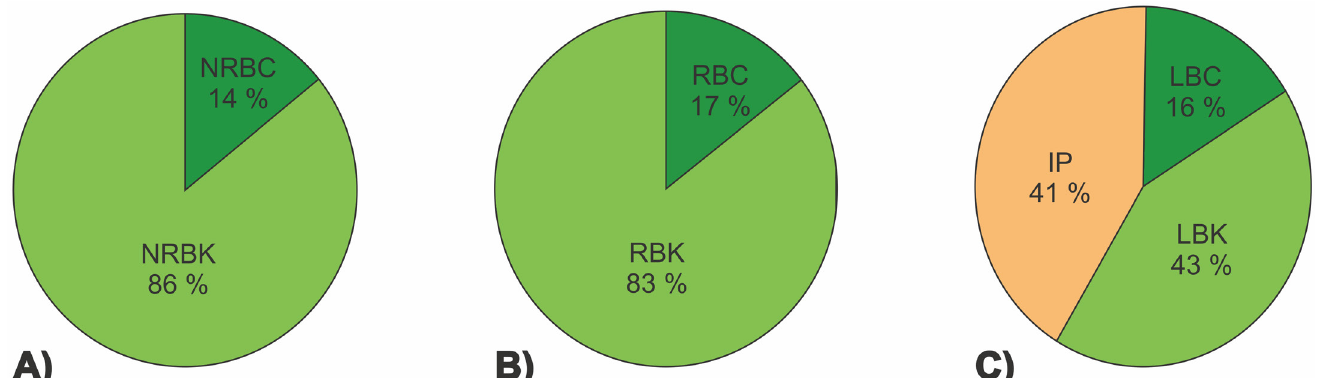
Figure 3: Number of TSES (Territorial System of Ecological Stability) elements in the case study region Kyjovsko in the Czech Republic shown as the share of A) supra-regional bio-corridors (NRBK) and supra-regional bio-centres (NRBC), B) regional bio-corridors (RBK) and regional bio-centres (RBC), and C) local bio-corridors (LBK), local bio-centres (LBC) and interaction elements